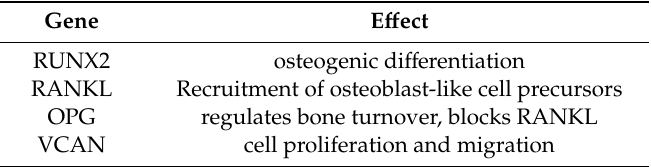
Table 2. WNT pathway target genes and the e ff ect of each on the